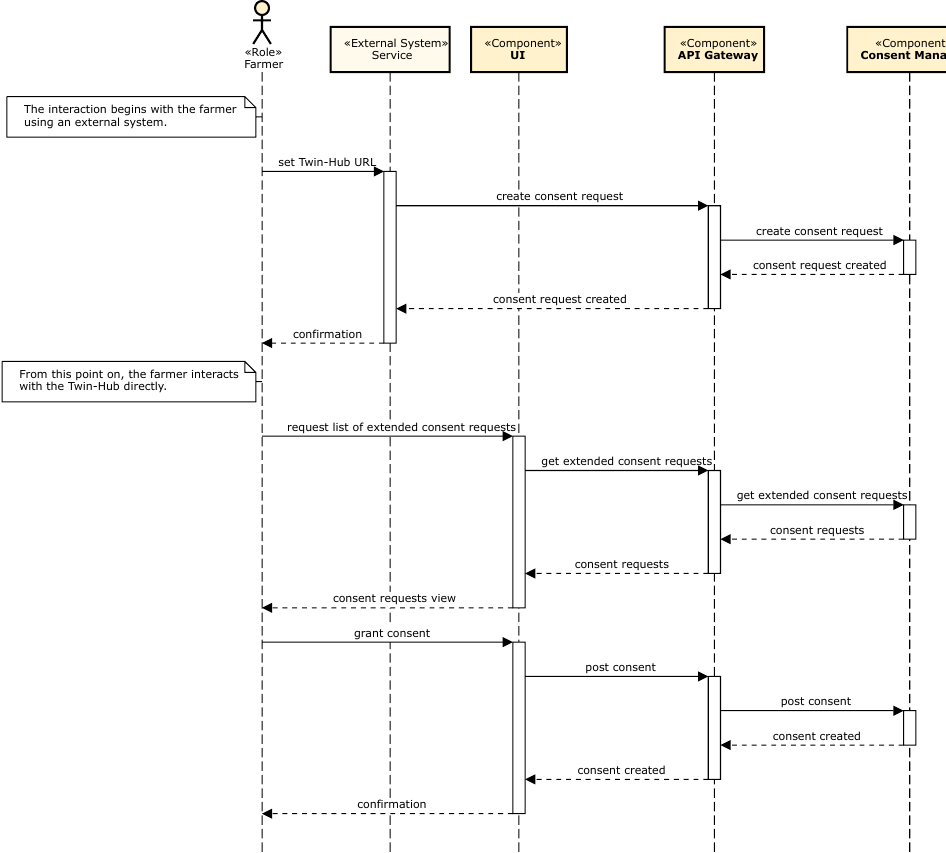
Figure 7. Sequence diagram of a consent request. First, the farmer provides the service with the URL of their Twin-Hub instance; next, the service prepares and sends a consent request to the Twin-Hub; then the farmer sees the pending consent request on their Twin-Hub, extended by the list of fields to be included in the consent; finally, the farmer decides to which fields they want to grant the service access and confirms the grant, creating a